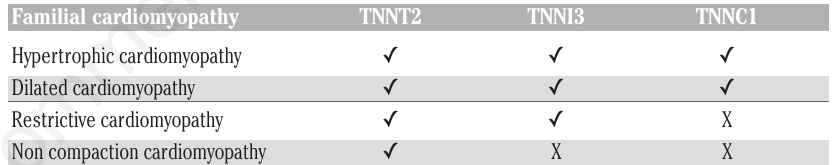
Figure 1. Timeline illustrating the history of troponin, from its discovery to its modern-day use. Table 2. Troponin genes associated with familial